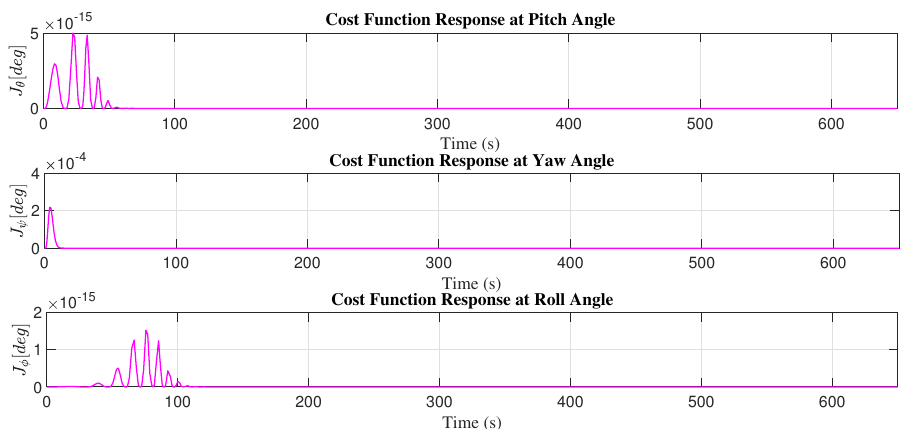
Figure 15. Controller response with MIT rule.